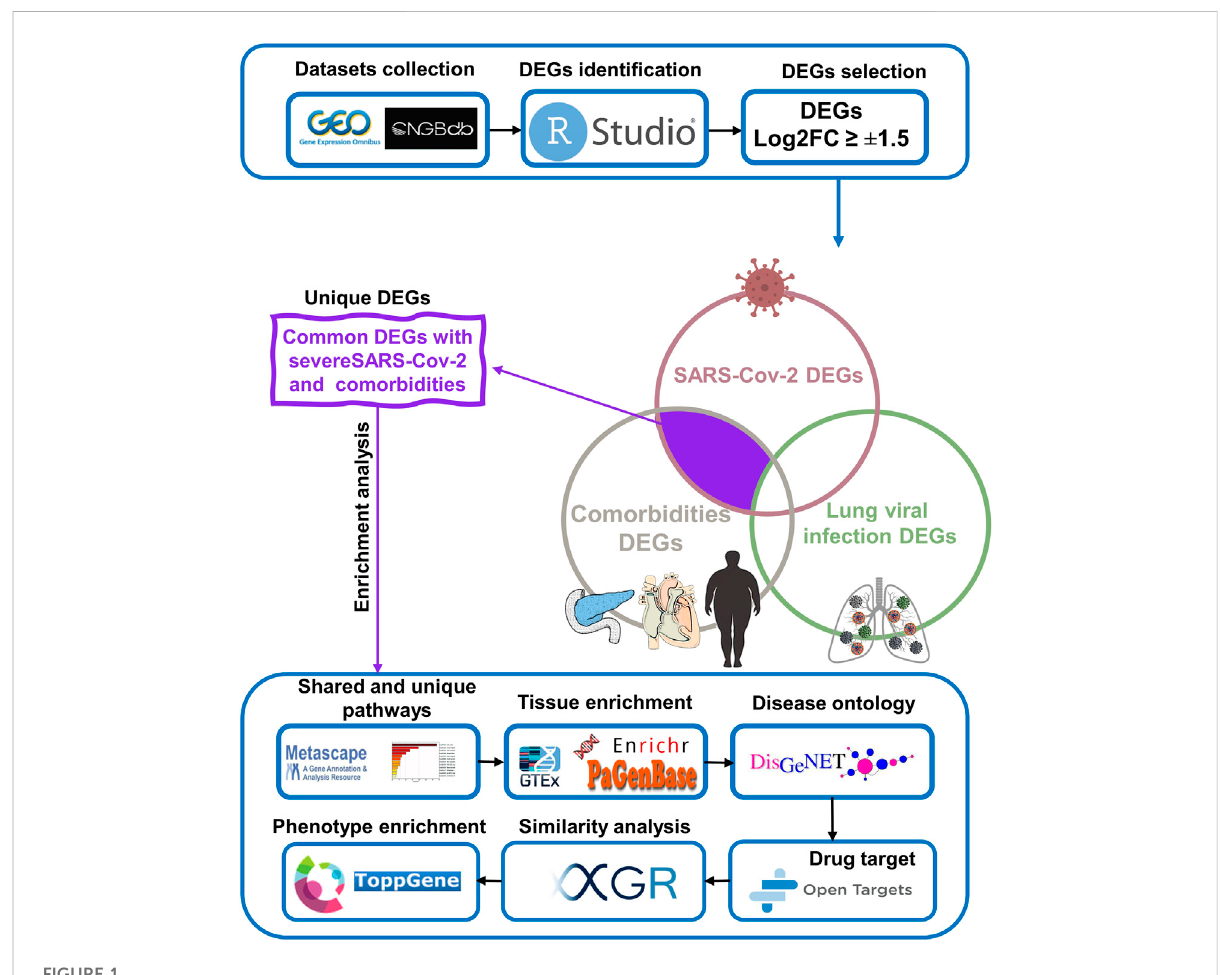
FIGURE 1 Schematic work fl ow of the